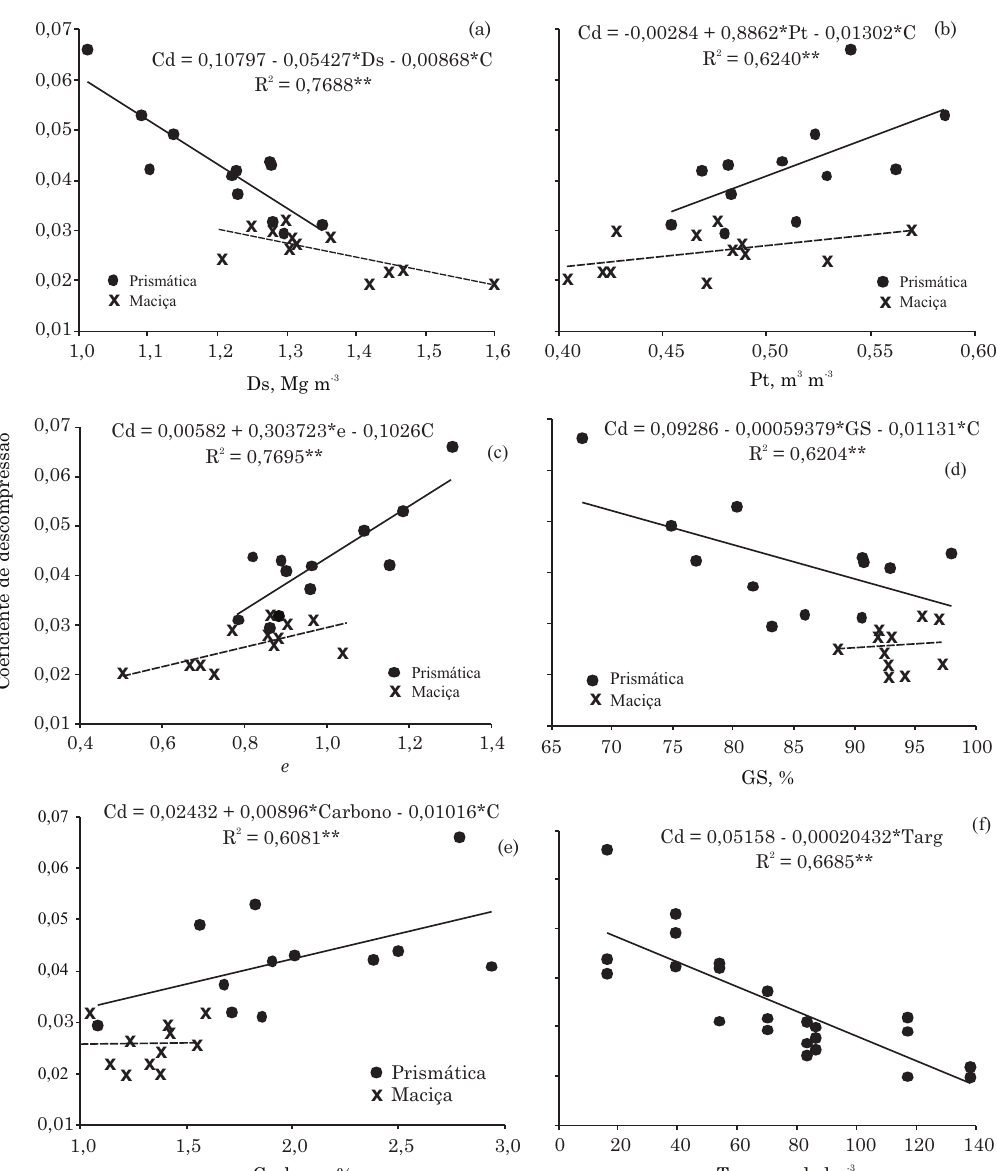
Figura 2. (a) Regressão linear do coeficiente de descompressão em razão da densidade do solo (Ds), (b) porosidade total (Pt), (c) índice de vazios ( e ), (d) grau de saturação (GS), (e) carbono e (f) atividade da argila (Targ) para o Gleissolo Háplico. C refere-se à classe de estrutura (valor 1,0 quando prismática e 0,0 quando maciça). ** e * significativo a 5 e 1 %, respectivamente. N =